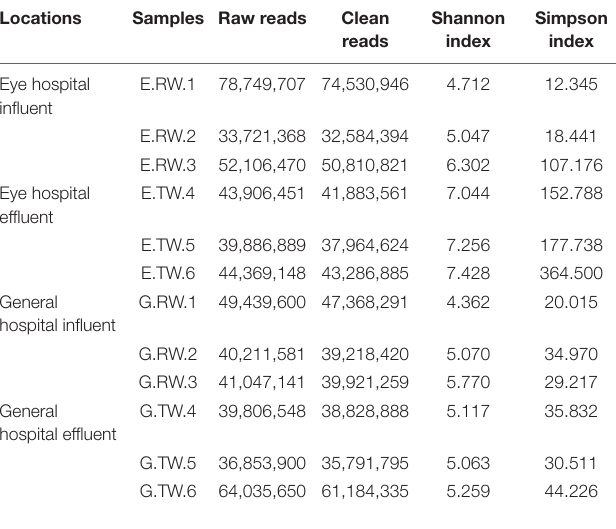
TABLE 1 | List of samples used and overview of the total number of raw sequences and clean sequences, Shannon index, and Simpson index obtained for each